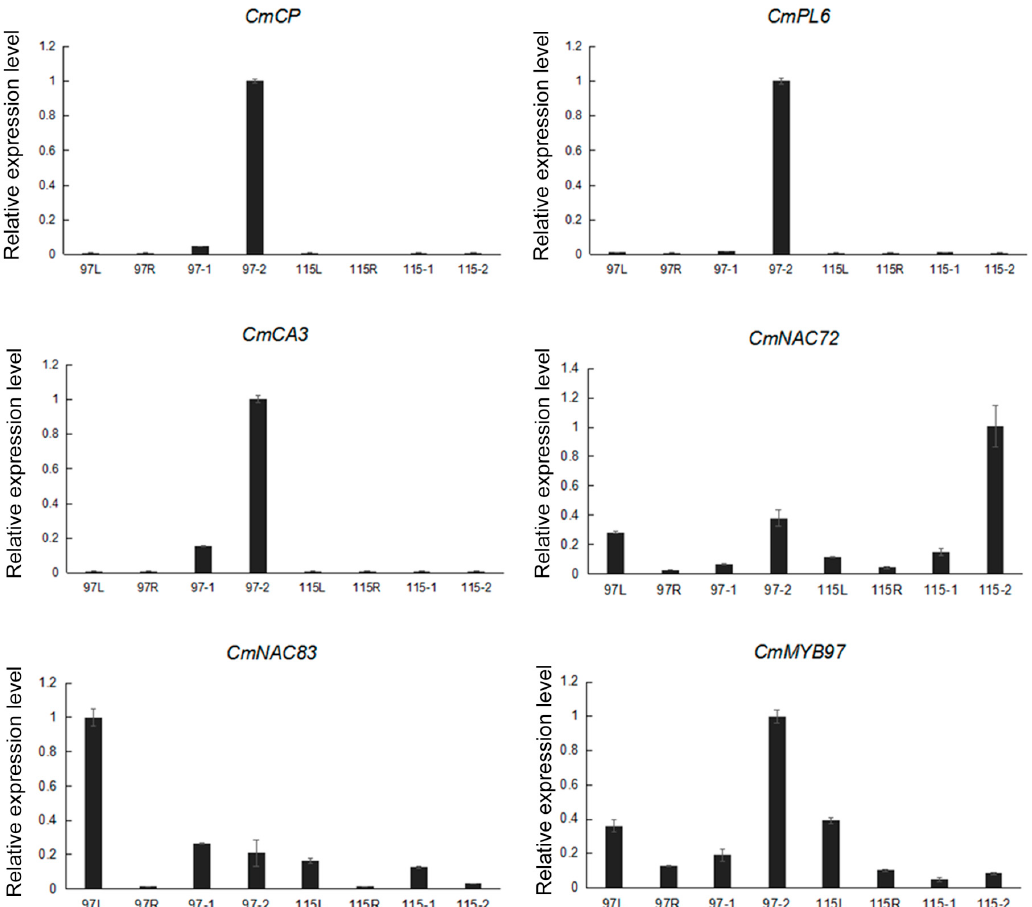
Figure 7. Quantitative real-time PCR (qRT-PCR) expression analysis of genes in different tissues and at different developmental stages in the chrysanthemum cultivars ‘Qx-097 ′ and ‘Qx-115 ′ . 97L, ‘Qx-097 ′ leaves; 97R, ‘Qx-097 ′ ray flowers; 97-1, ‘Qx-097 ′ anthers at period 1; 97-2, ‘Qx-097 ′ anthers at period 2; 115L, ‘Qx-115 ′ leaves; 115R, ‘Qx-115 ′ ray flowers; 115-1, ‘Qx-115 ′ anthers at period 1; 115-2: ‘Qx-115 ′ anthers at period 2. Data represent mean ± standard deviation (SD; n = 3).